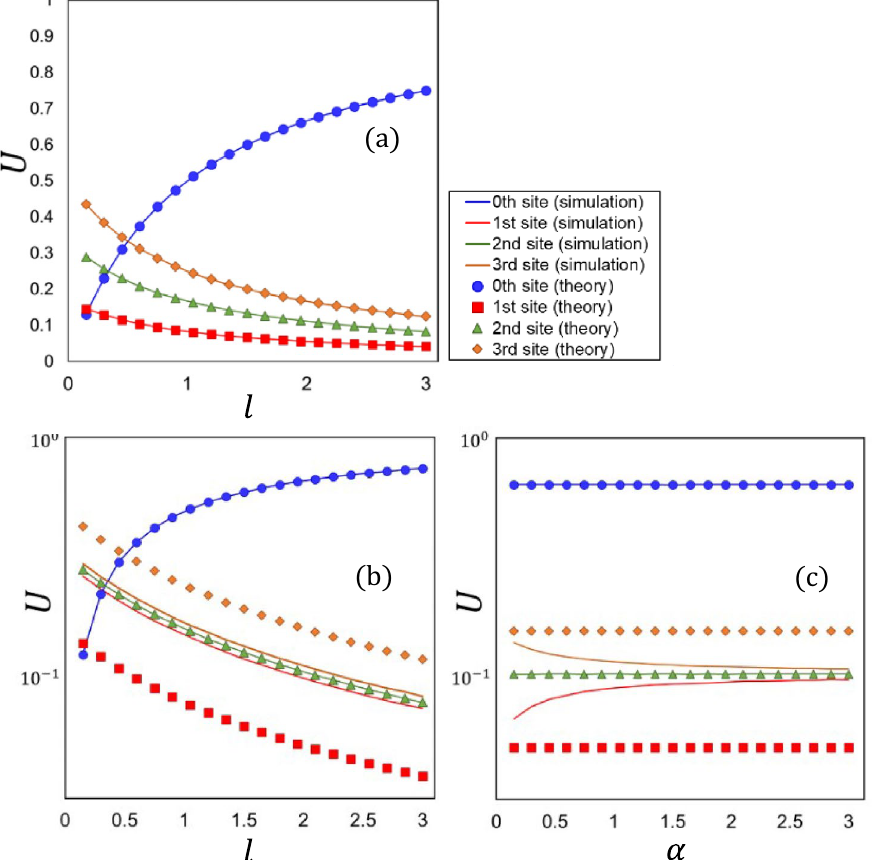
0 for different = 2.5 for different values of l = 0 , and ( c ) comparison of simulations at l 2.0 for different = = 0 =